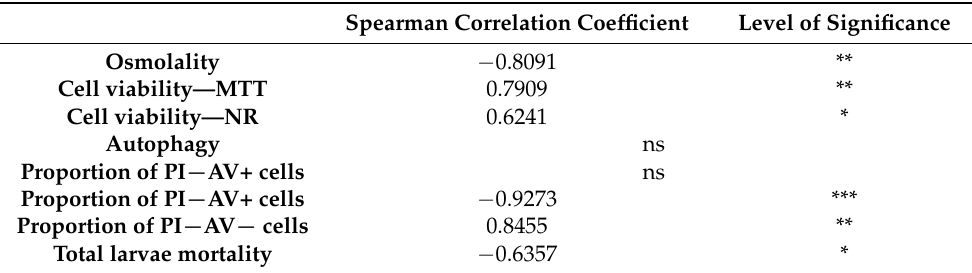
Table 1. Correlation of measured data (only PEGs) with average molecular weight calculated by Spearman method. Significance levels are shown as: ns = p ≥ 0.05; * = p < 0.05; ** = p < 0.01 and *** = p < 0.001.